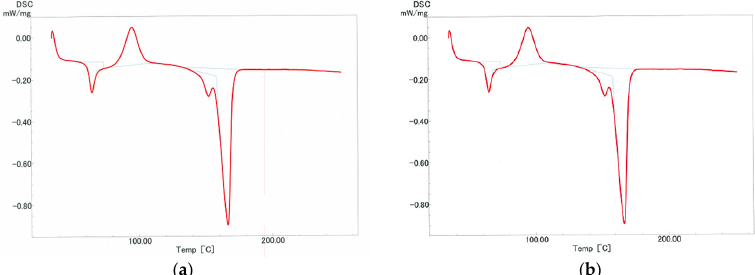
Figure 4. Differential scanning calorimetry (DSC) analysis of polylactic acid (PLA). ( a ) Untreated PLA and ( b ) decomposed PLA at 180 °C for 10 min. Table 3. Heat of crystallization and heat of fusion of polylactic acid (PLA).